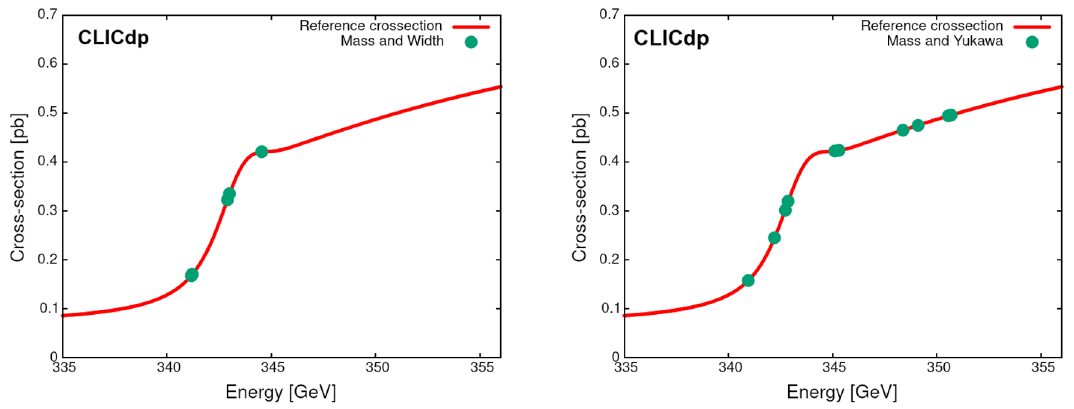
Figure 13 . Scan energy points for the “best scenarios” taken from the last generation compared with the reference cross section template: (left) 5 point scenario optimised for mass and width determination precision (two points below, two in the middle and one above the threshold) and (right) 10 point scenario optimised for mass and Yukawa coupling determination precision.